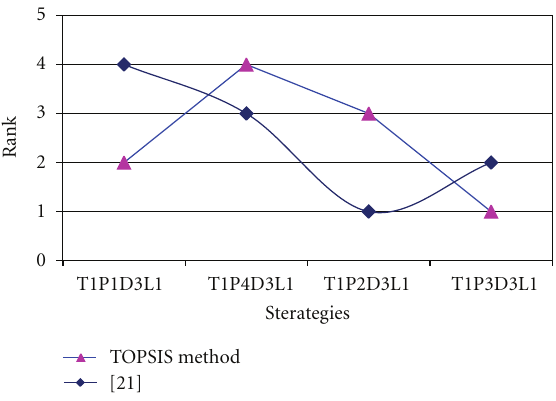
is T1P1D4L1 and the worst one is T1P4D2L1.